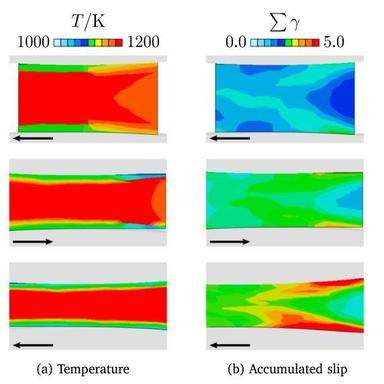
Results from the hot rolling simulation, quantities mapped onto the work piece in the mill from first (top) to third pass (bottom). Arrows indicate Rolling Direction (RD). Figure adopted from.